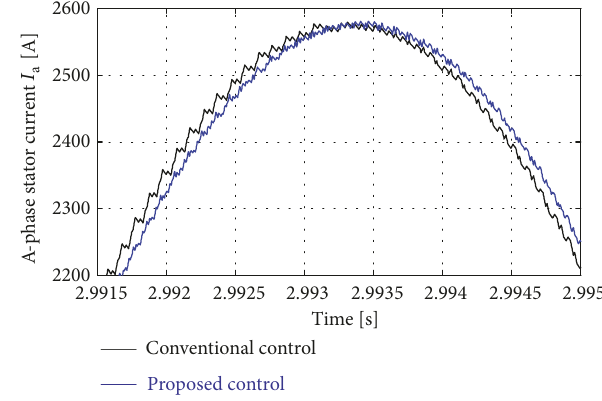
Figure 8: A-phase stator current waveform.